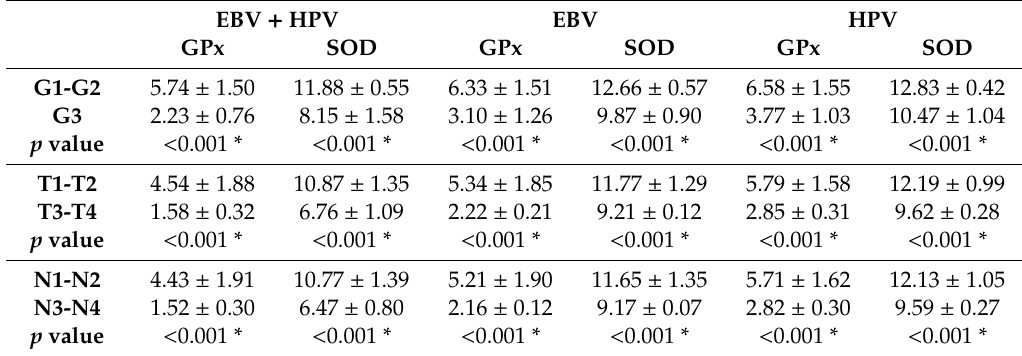
Table 3. Comparison between tissue activity of GPx (U / mg of protein) and SOD (U / 100 mg of protein) and G,T,N in EBV / HPV coinfection, EBV( + ) and HPV( + ) patients with oropharyngeal cancer. EBV + HPV EBV